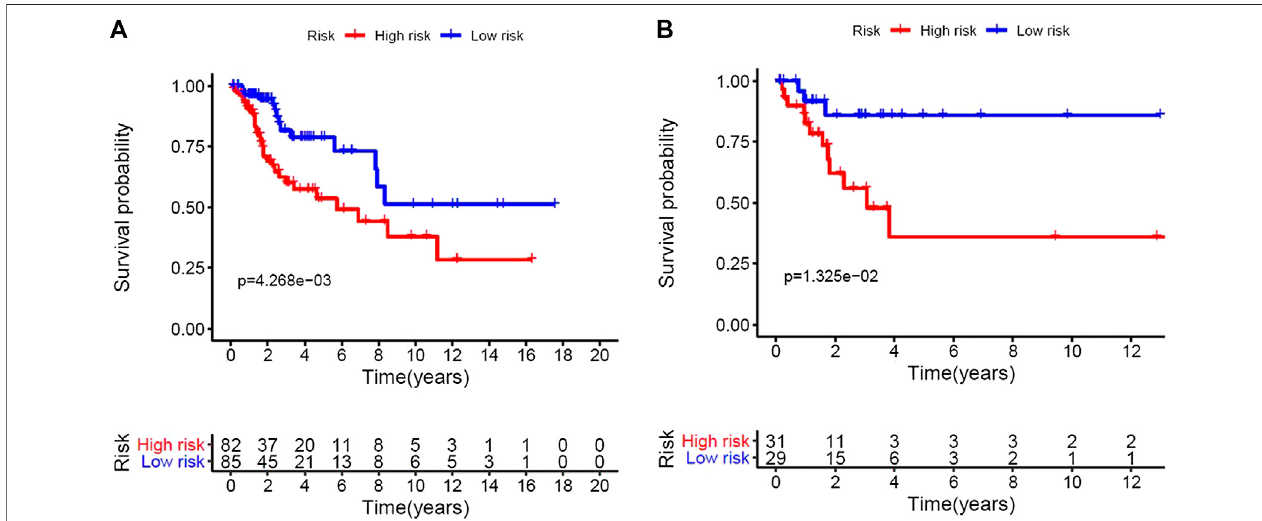
FIGURE 1 | Construction of the fi ve immune-related Long non-coding RNAs prognostic model of cervical cancer patients. Based on the median risk score, we divided patients from the training set into high-risk group with 84 individuals and low-risk group with 83 individuals. (A) , Kaplan – Meier curve of the high-risk and low-risk groups of training set showed differences in survival rate. (B) , Kaplan – Meier curve of the high-risk and low-risk groups of validation set also showed differences in survival rate.